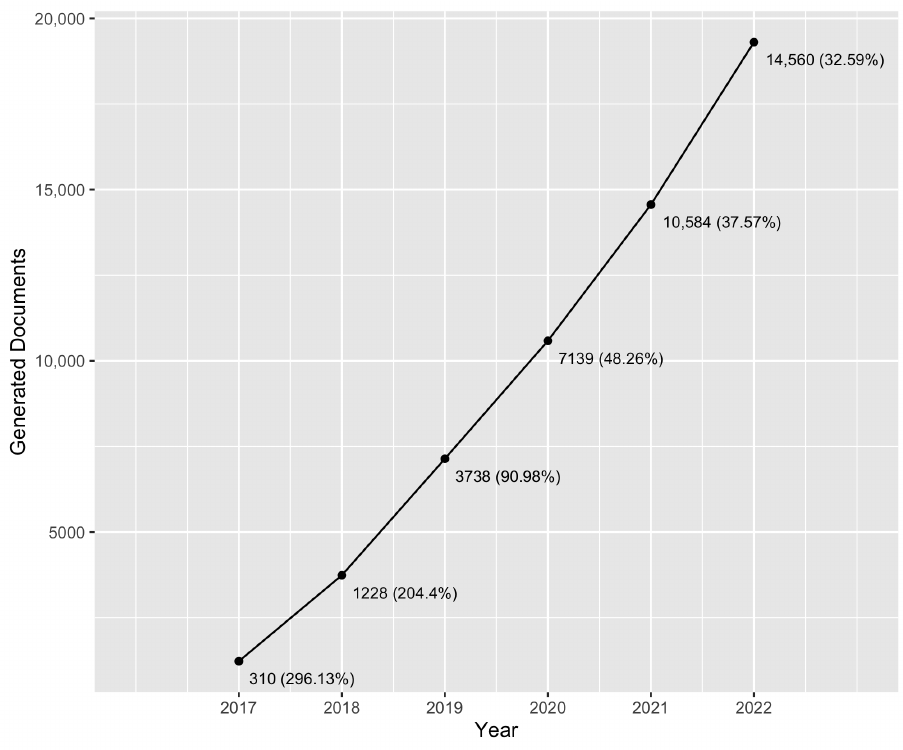
Figure 1. Collected documents per year.